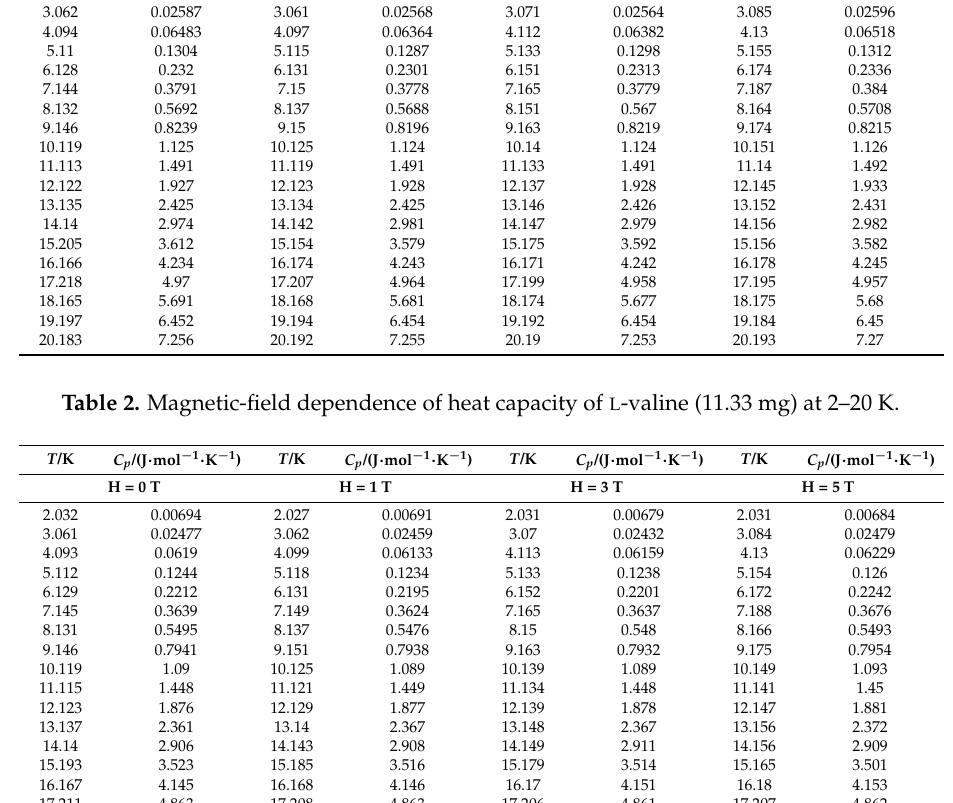
Table 2. Magnetic-field dependence of heat capacity of L -valine (11.33 mg) at 2 – 20 K. T /K